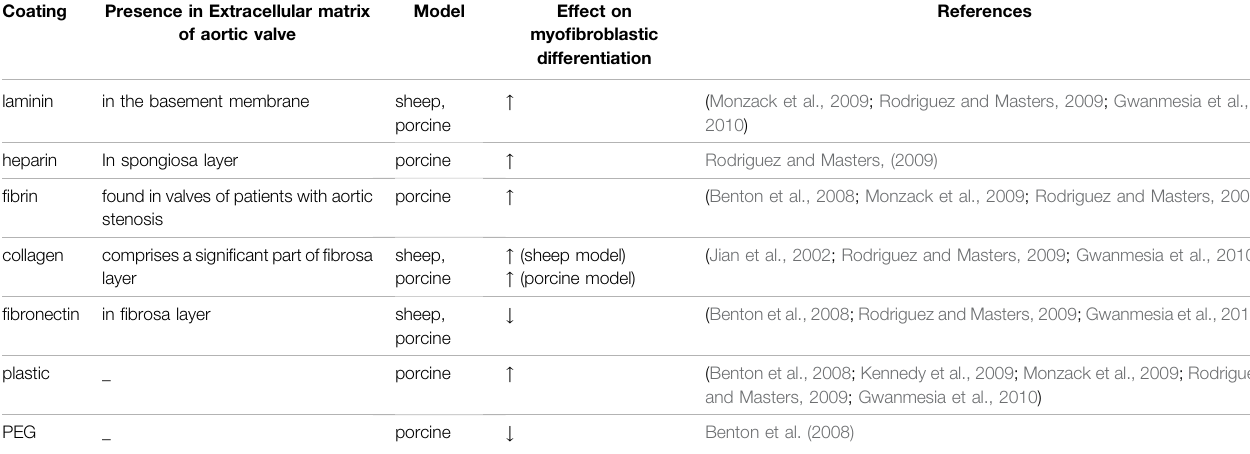
TABLE 1 | The effect of different coatings on myo fi broblastic differentiation of cultured valve interstitial cells from different species.